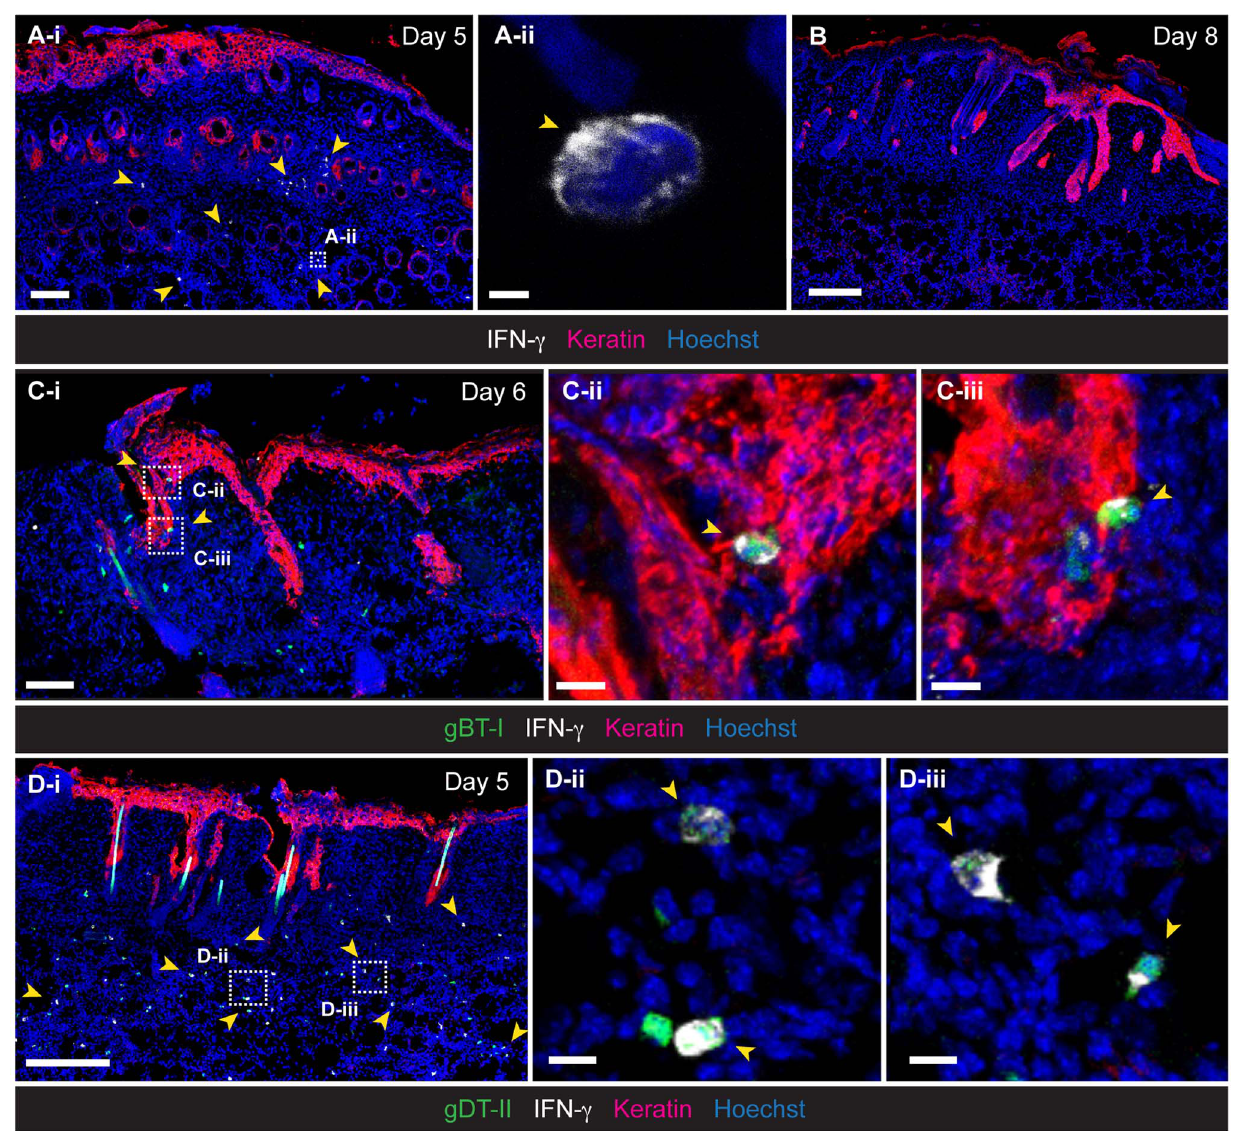
Figure 2. Localization of IFN- c + T EFF cells in infected skin. IFM analysis of skin, 5 ( A , D ), 6 ( C ) and 8 ( B ) days post-infection, stained with anti- keratin and -IFN- c antibodies, as indicated. ( C , D ) Detection of HSV-specific T EFF cells after transfer of GFP + naı¨ve gBT-I ( C ) and gDT-II ( D ) cells prior to infection. Scale bars: A-i , 100 m m; A-ii , 2 m m; B , 200 m m; C-i , 70 m m; C-ii , 10 m m; C-iii , 10 m m; D-i , 200 m m; D-ii , 10 m m; D-iii , 10 m m. Photos representative of n =4–6 mice/group.